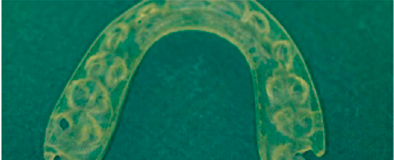
Figure 5. Osteosynthesis plate for the upper jaw.